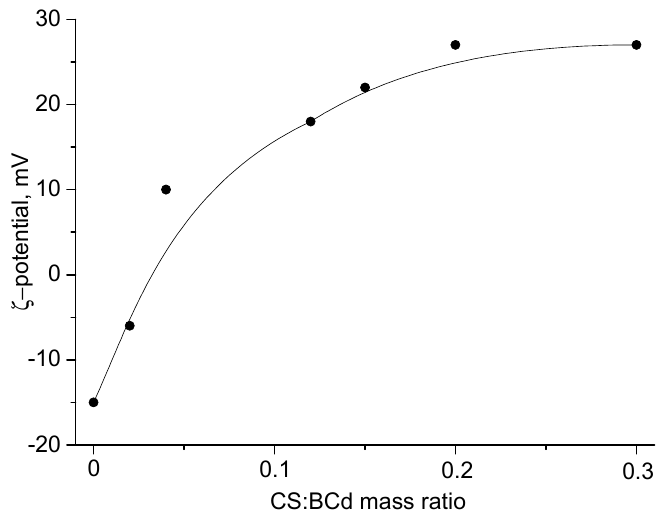
Figure 2. Changes in the ζ -potential of aqueous BCd dispersion (0.48 mg/mL) when adding a solution of chitosan (CS) in 2% acetic acid (0.48 mg/mL).